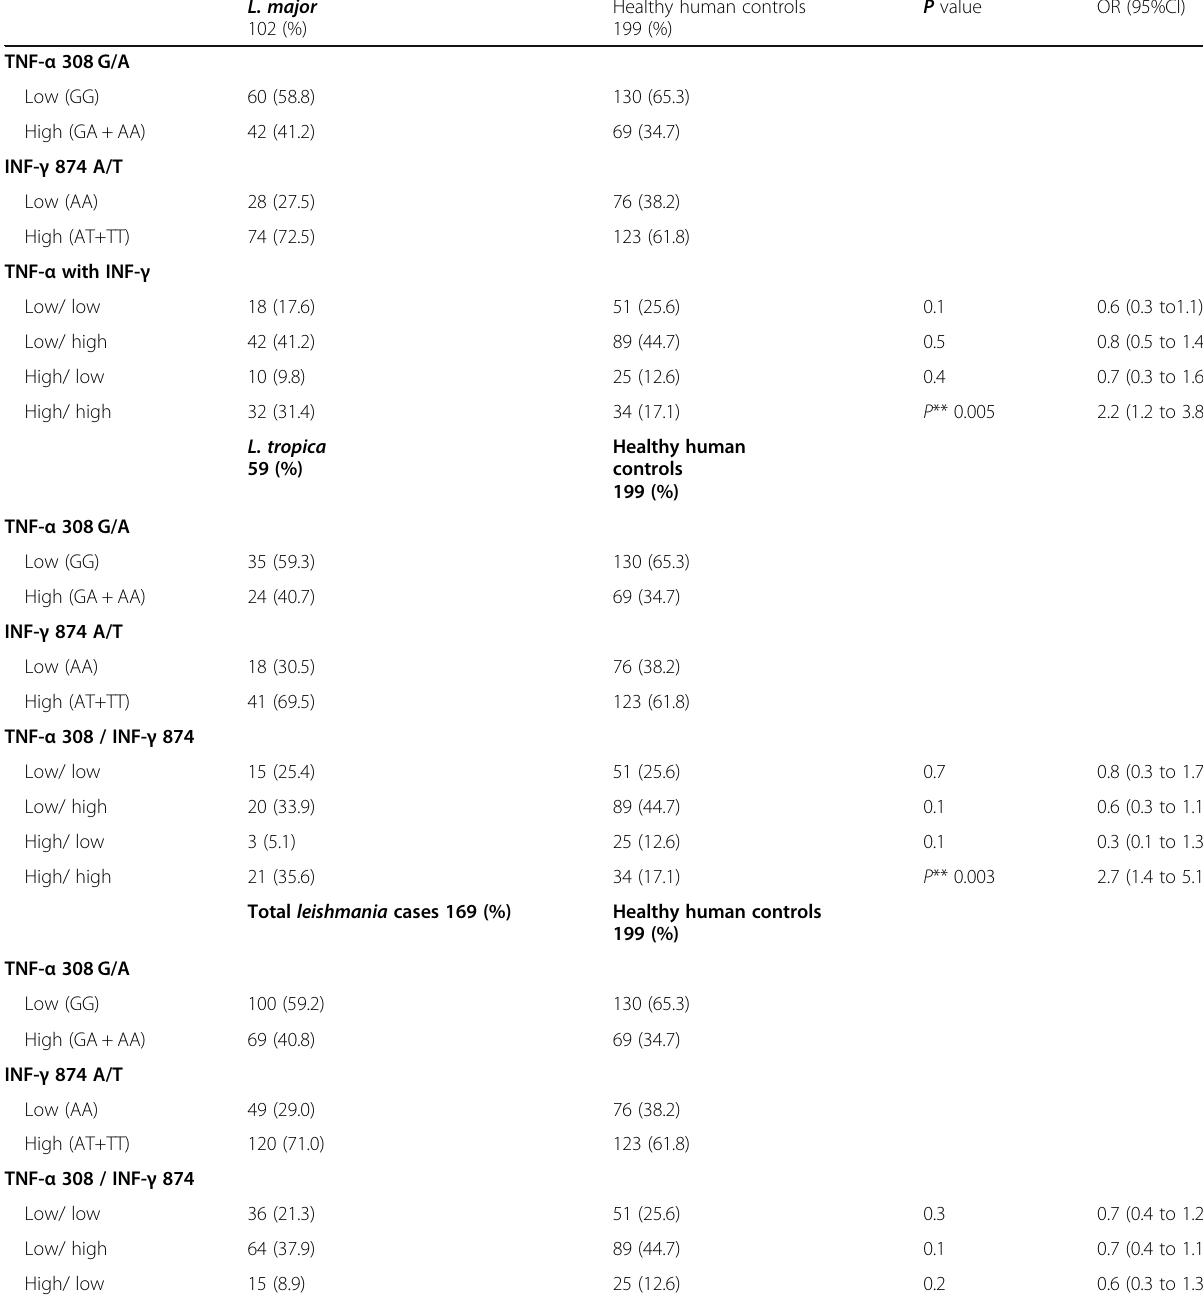
Table 5 Synergistically combined genotype frequencies of TNF- α -308 G/A and INF- γ 874 A/T in different species of leishmaniasis and healthy human